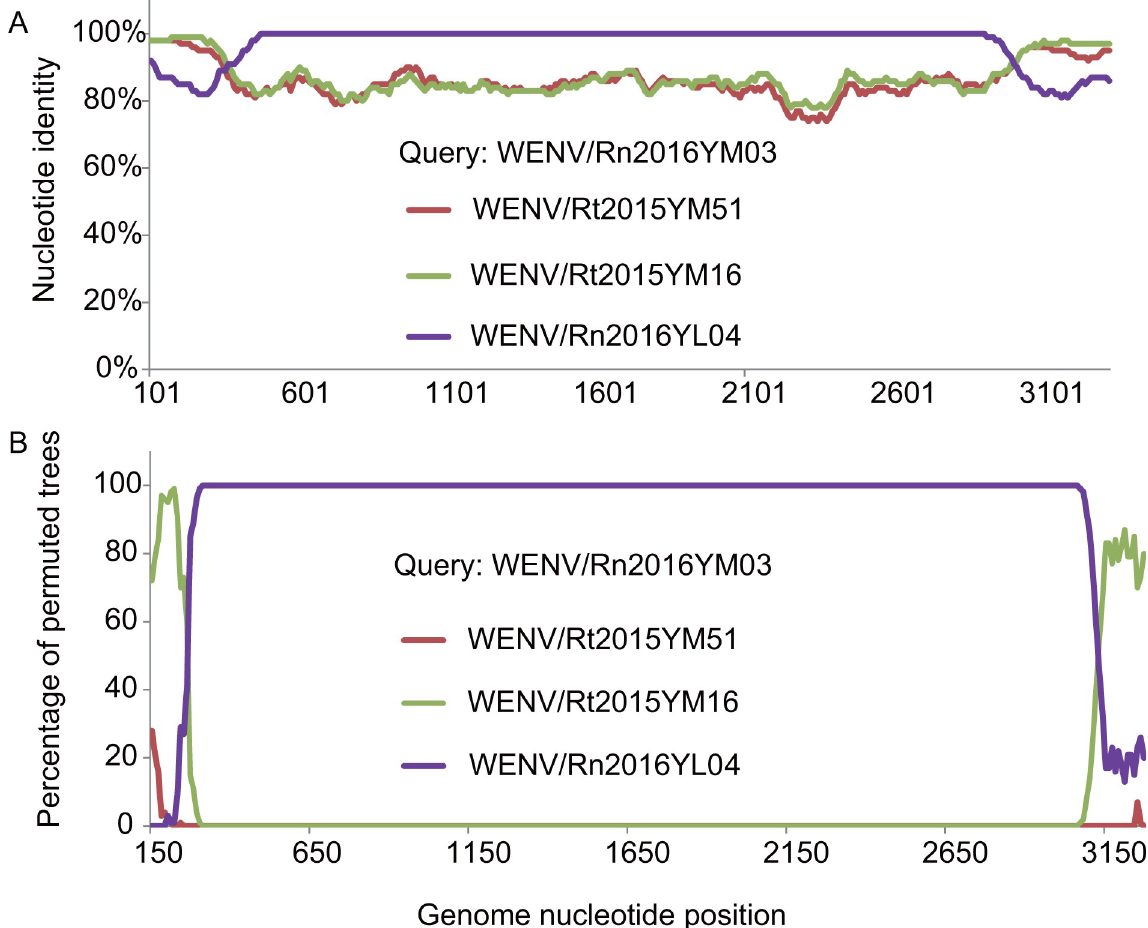
Fig 4. Recombination events detected by similarity plot and boot scan analysis. (A) The similarity of WENV/Rn2016YM03 and Rt2015YM03, Rt2015YM16, and Rn2016YL04 S segment sequences. (B) The recombination events detected by boot scan,